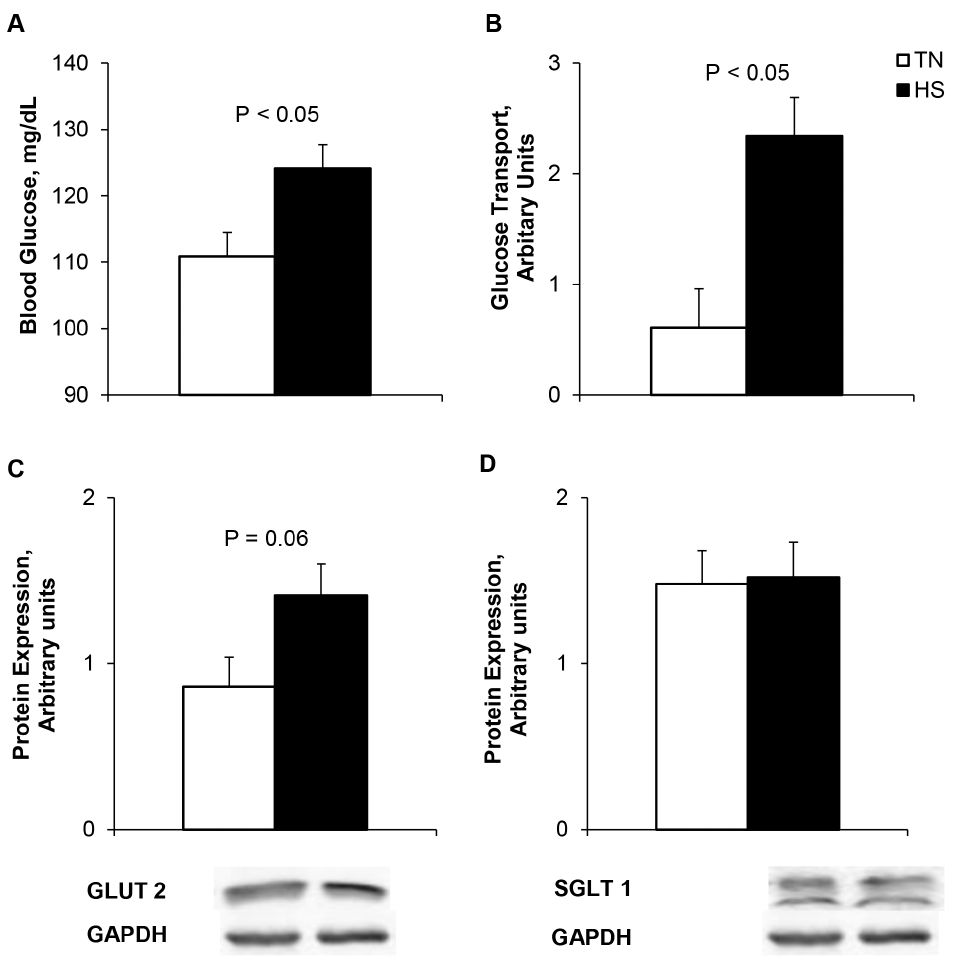
Figure 5. The effects of 24 hours of either constant thermal neutral conditions (TN; 21 u C) or heat stress conditions (HS; 35 u C) on a) blood glucose, b) active glucose transport, c) GLUT-2 expression, and d) SGLT-1 expression in growing pigs. n=8/trt.